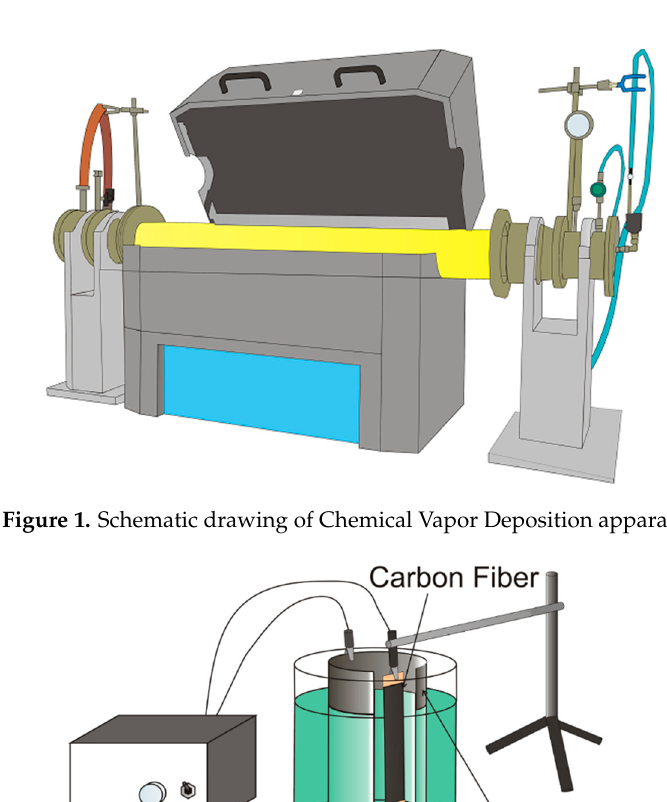
Figure 4. Schematic drawing of experimental setup for measuring the temperature history of heating element. Figure 5. Schematic drawing of experimental setup for measuring the temperature history of welded zone. Figure 6. Schematic drawing of flexural test of a welded specimen.